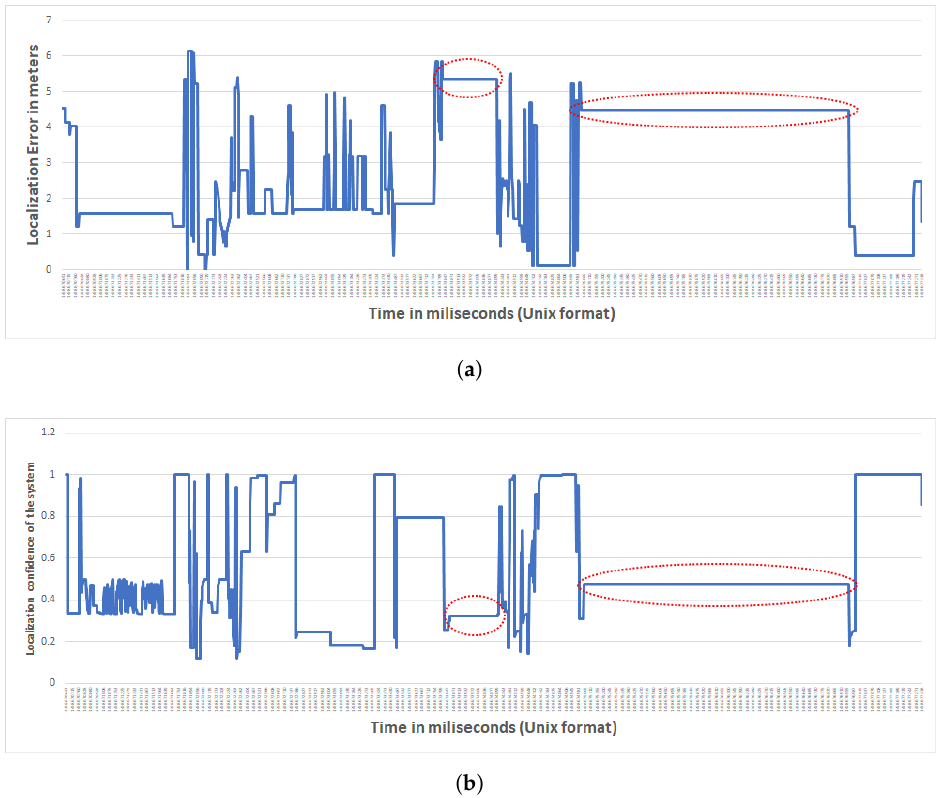
Figure 5. Figures ( a ) and ( b ) are from the same single occupant session. ( a ) Error of the localization for one of the single occupant sessions; ( b ) Confidence of the system on localizing one of the single occupant